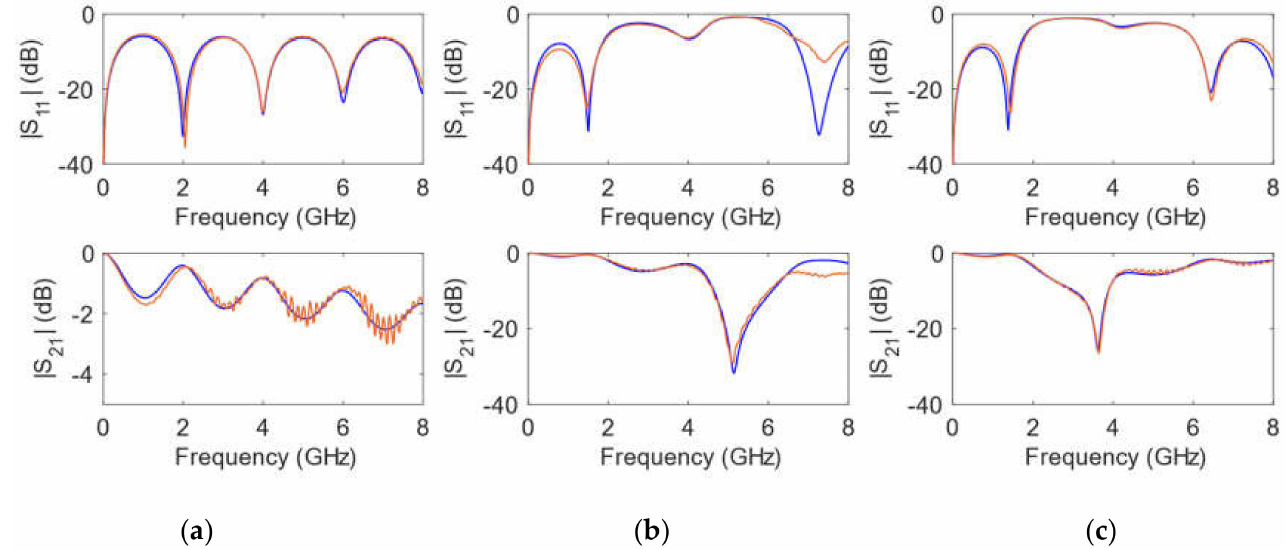
Figure 6. Simulated ( blue ) and measured ( orange ) calibrating elements magnitude of scattering parameters for a h = 1 mm substrate height. ( a ) transmission line; ( b ) short stub; ( c ) long stub.